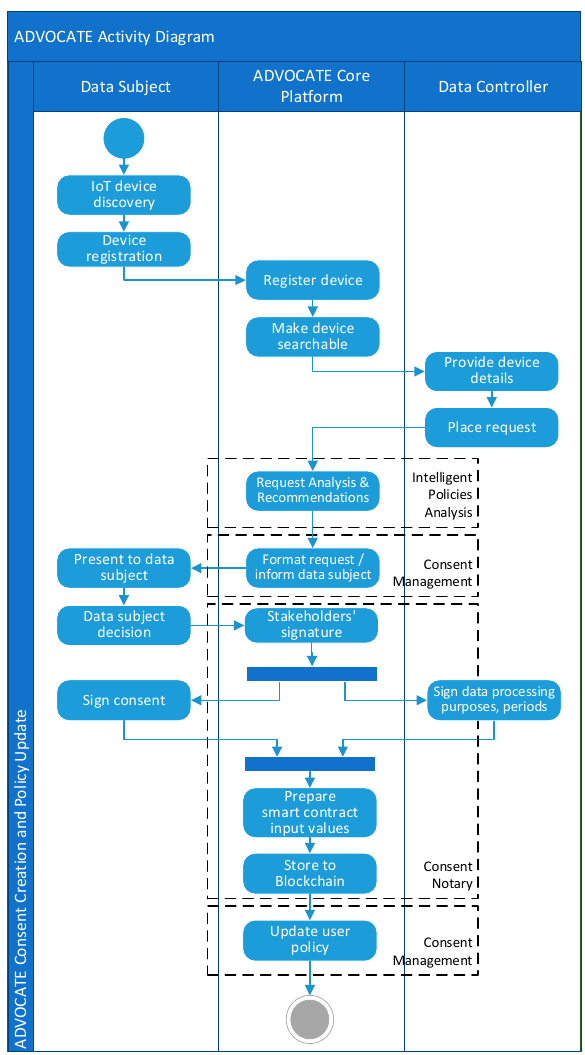
Figure 2. Interaction of ADVOCATE components during the introduction of new consents.